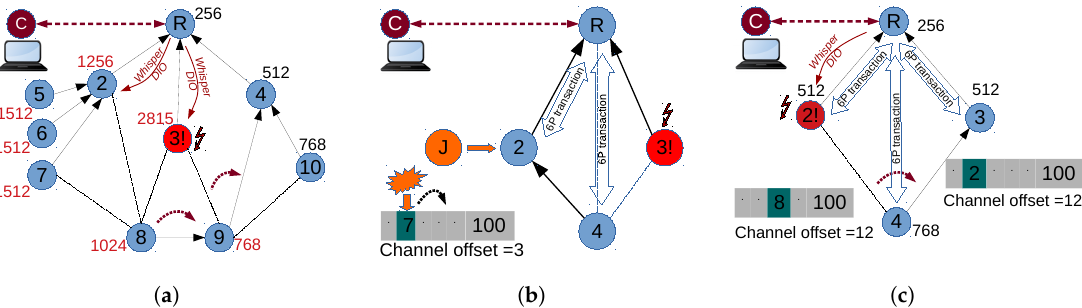
Figure 2. Whisper better supports dynamic management use cases, impossible to handle with only current IoT protocols. ( a ) rerouting around low-battery node while load balancing; ( b ) jamming defense; ( c ) smooth parent